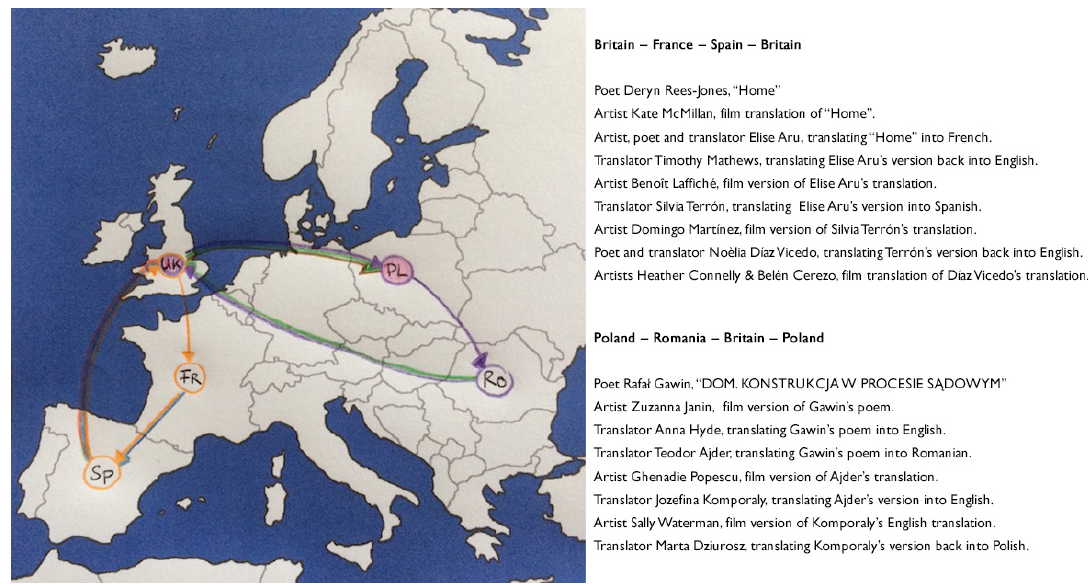
Figure 1. Talking Transformations : Eastern and Western European translation